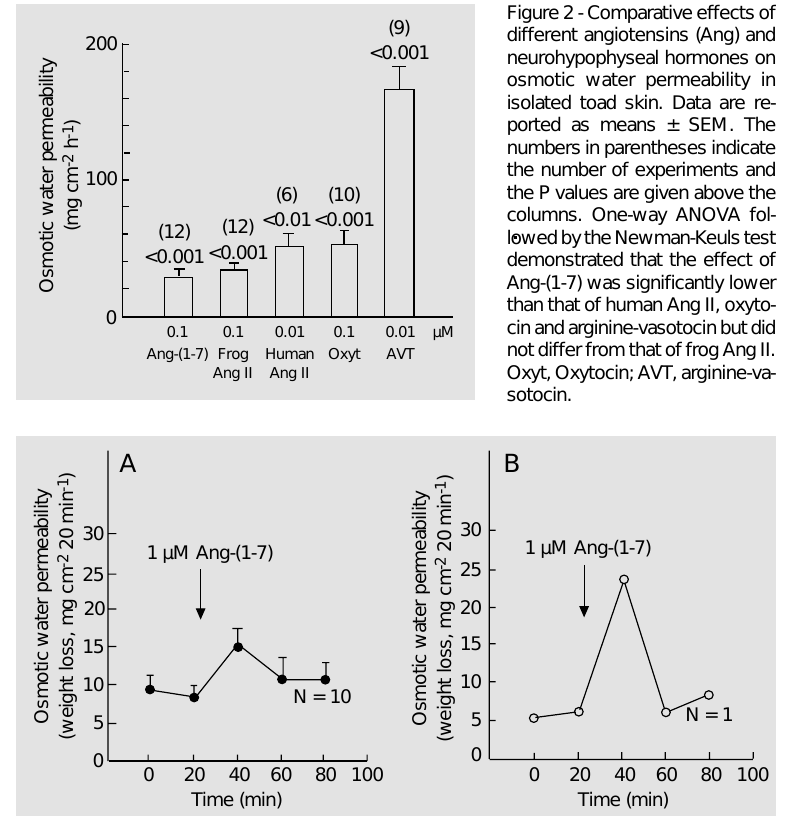
Figure 4 - Lack of effect of the specific Ang-(1-7) antagonist (A- 779) on osmotic water perme- ability stimulated with Ang-(1-7). Data are reported as means ± SEM. One-way ANOVA followed by the Newman-Keuls test showed no significant differ- ences (N.S.) between e 1 and e 2 or c 1 and c 2 . In this and the fol- lowing figures c 1 and e 1 are the control and experimental periods of one skin half and c 2 and e 2 the control and experimental periods of the other paired